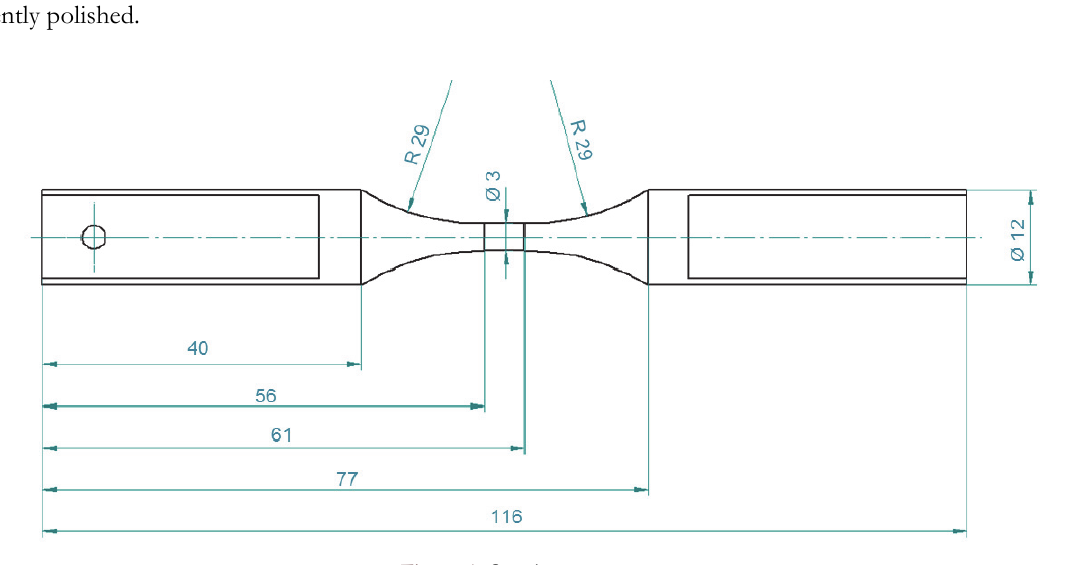
Figure 1: Specimen